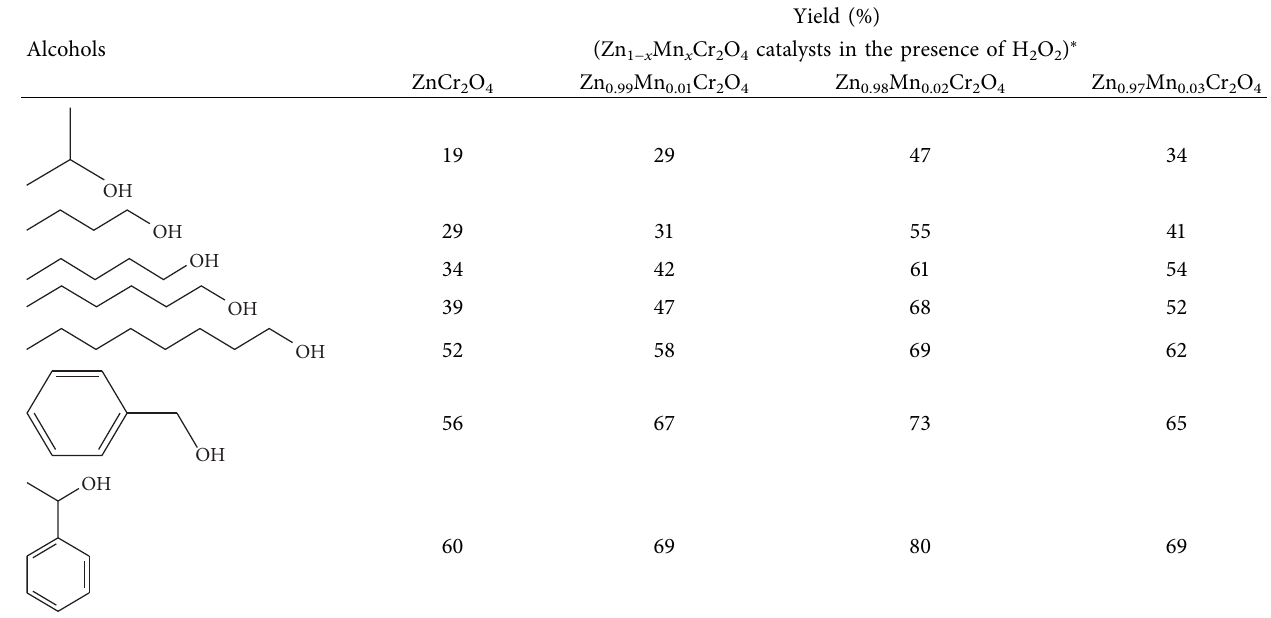
Table 3: Oxidation of various alcohols with ZnCr Alcohols